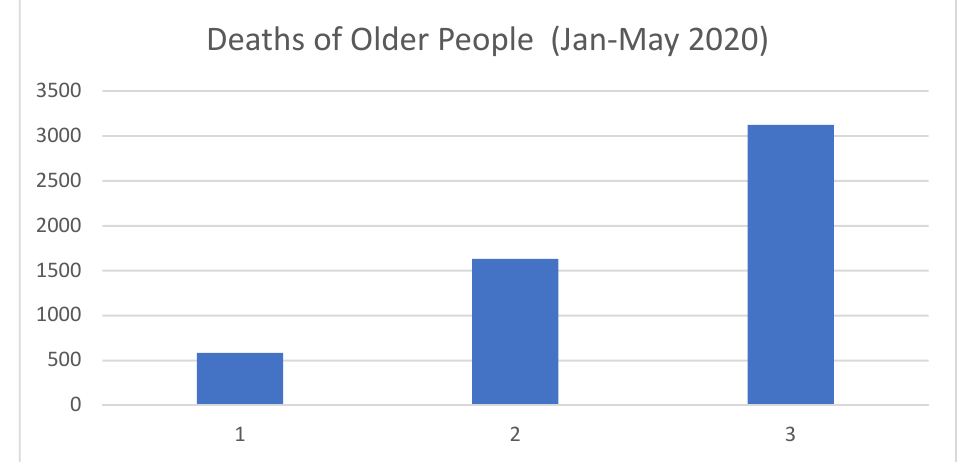
Figure 13. COVID-19 deaths in Milan (1 = Age 65–74, 2 = 75–84, 3 = over 85). Source: (istat 2022).